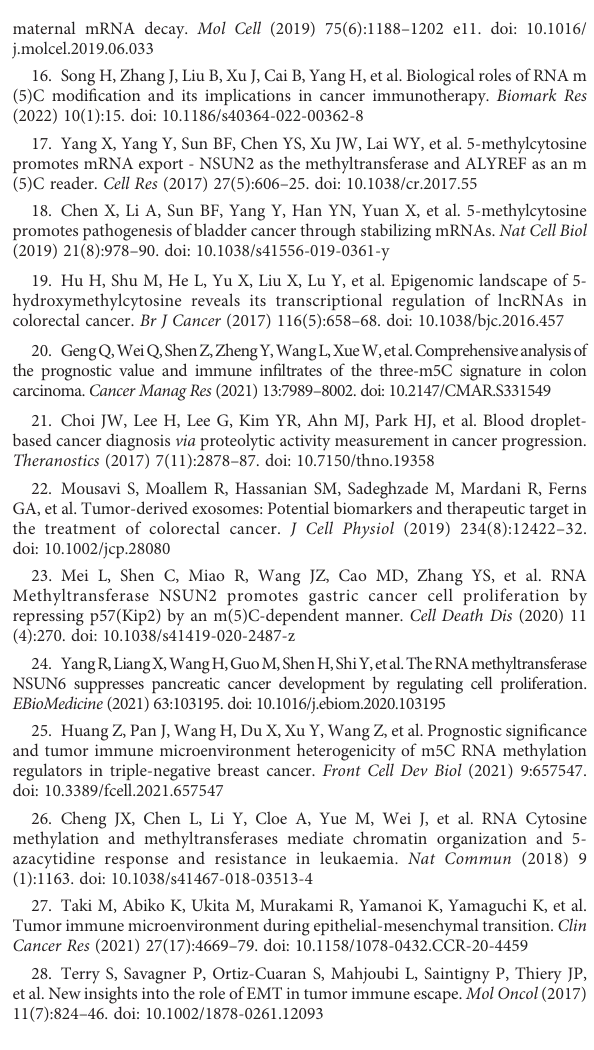
blood immune cells in the training set (A) and validation set (B) . (C) ROC curve for m 5 C modi fi cation of early-stage CRC in the validation set. SUPPLEMENTARY FIGURE 3 The representative morphology and tumor weight (A) Representative tumor morphology of the colon from AOM/DSS mice were shown. (B) Tumors number of AOM/DSS mice and Apc-L850X mice. (C) Tumor weight of MC38 Syngeneic mice and DLD-1 Xenograft mice. SUPPLEMENTARY FIGURE 4 Expressions of m 5 C-modi fi ed regulators NSUN5 and YBX1 in peripheral blood immune cells of the validation set. (A, B) qRT-PCR analysis of NSUN5 (A) and YBX1 (B) mRNA expression levels in blood immune cells of HC and CRC patients in the validation set. (C) Correlation between the levels of TET2 and m 5 C in the training set. (D) Correlation between the levels of NSUN5 and m 5 C in the validation set. (E) Correlation between the levels of YBX1 and m 5 C in the validation set. (F) m 5 C levels in monocytes from CRC patients (n=12) were higher than those in non- monocyte immune cells (n=12). (G) Western blot analysis of NSUN5 and YBX1 protein expression in THP-1 with or without SW620